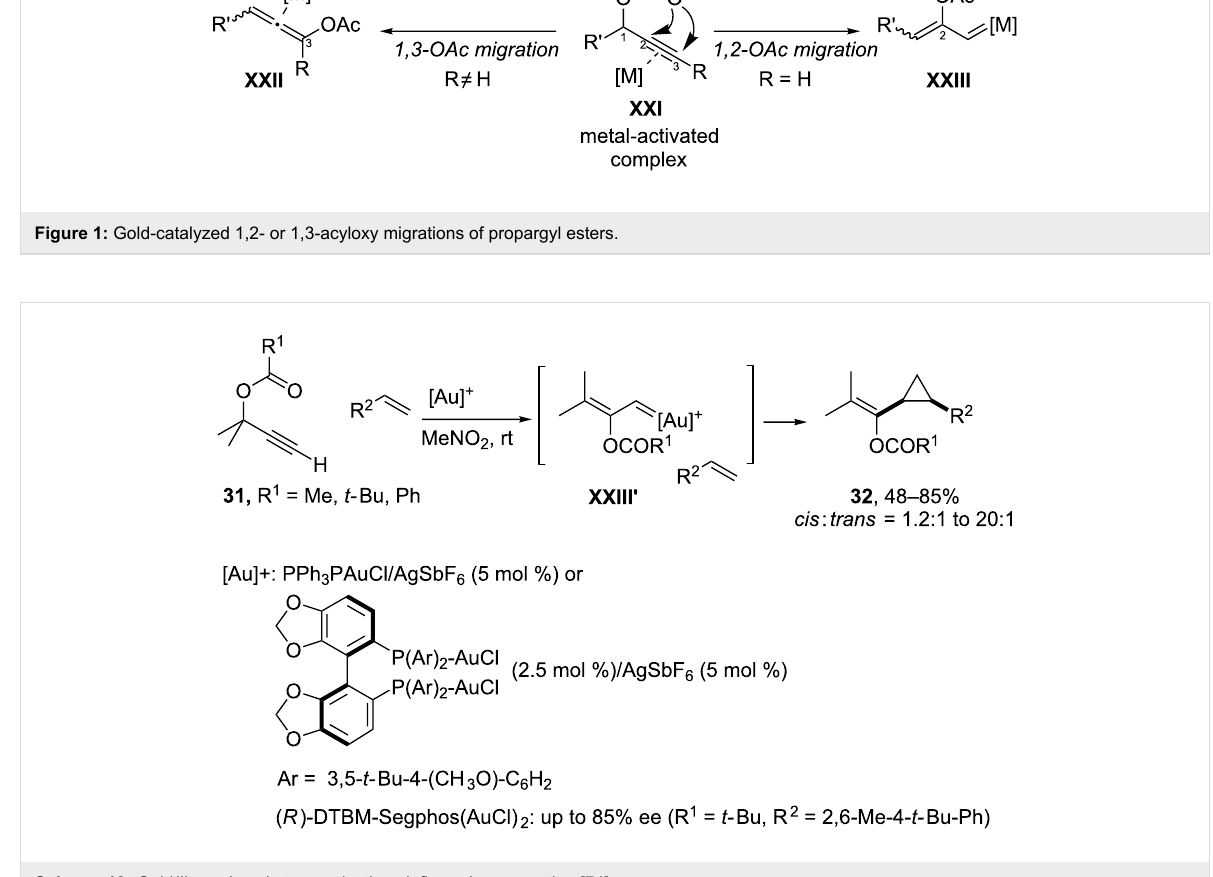
Scheme 19: Gold(I)-catalyzed stereoselective olefin cyclopropanation